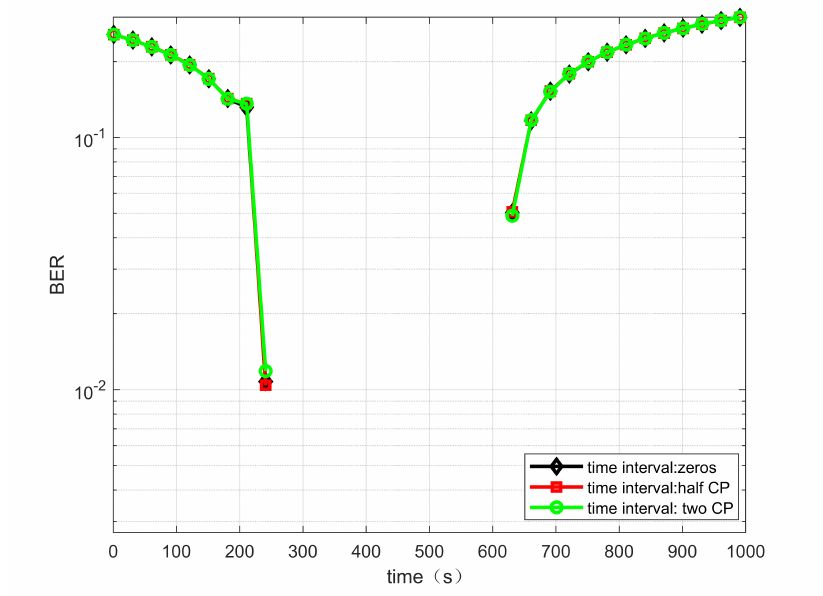
Figure 7. BER performance versus time for the link between satellite 2 and IoT terminal.